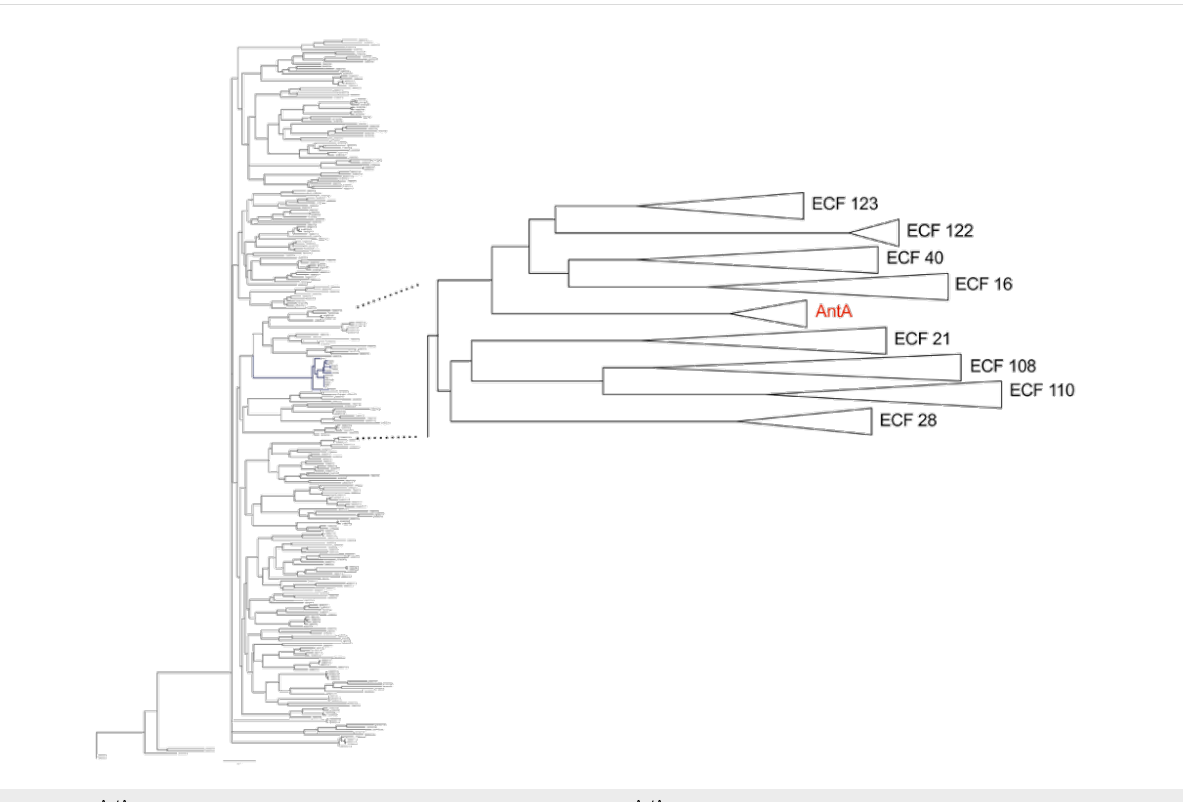
Figure 4: σ AntA comprises a new subfamily of ECF RNA polymerase σ factors. σ AntA amino acid sequences were aligned to amino acid sequences of random representative of each ECF RNA polymerase σ factor subfamily reported by [39] using Clustal Ω [40]. The phylogenetic tree was created using PhyML 3.0 [41] and visualised using FigTree v1.4. The relevant region of the phylogenetic tree is enhanced for visualisation and reveals that all σ AntA protein sequences cluster together and have a distinct phylogenetic lineage and represents a new ECF RNA polymerase σ factor